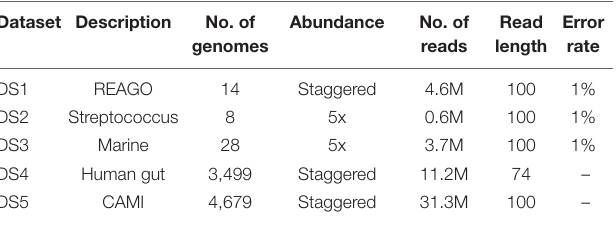
TABLE 1 | Summary of experimental datasets. Dataset